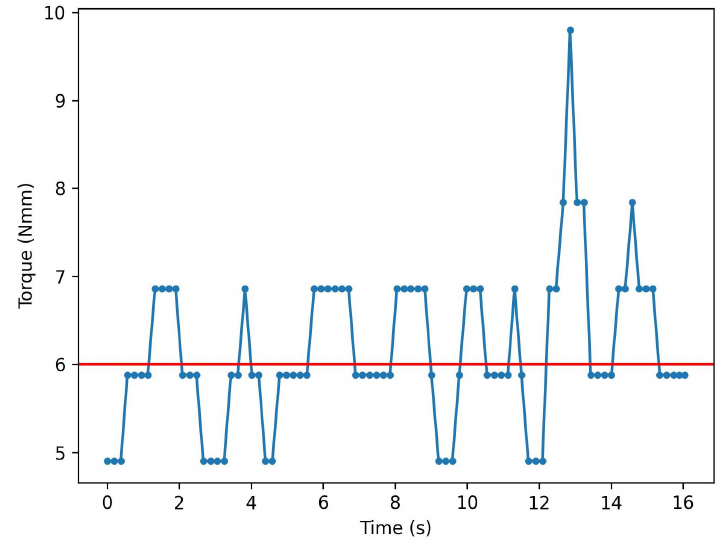
Figure 11. The experimental results of permanent magnet driving